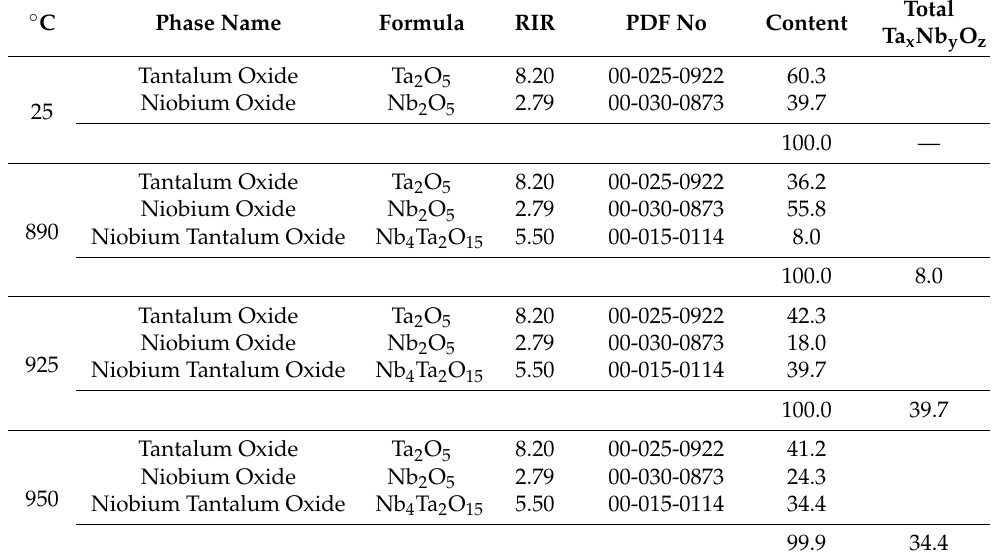
Table 8. Quantitative phase analysis results (WPF) from the high-temperature XRD scans of a 30 mol%